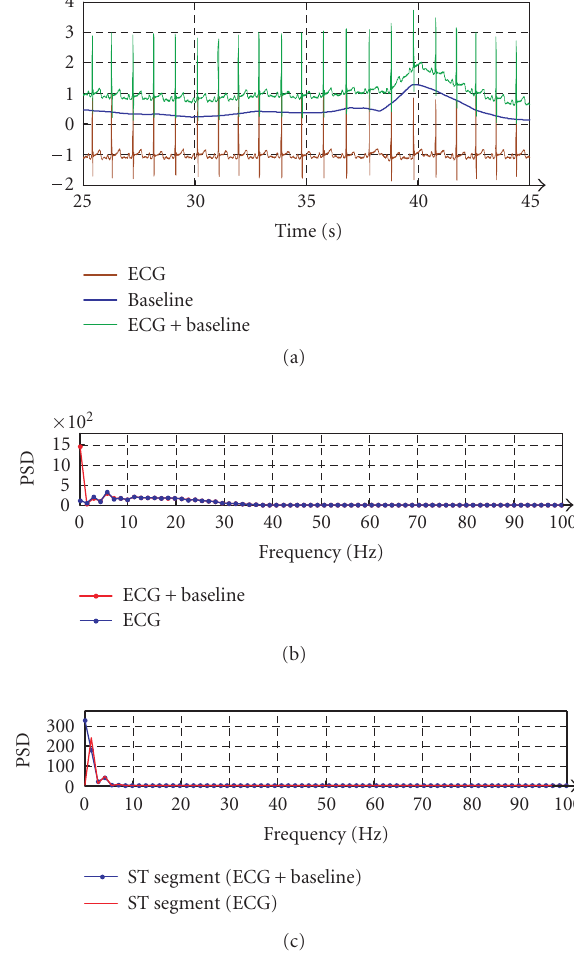
Figure 12: (a) 20 seconds of record “b115-1” highlighted, (b) power spectrum density of record “b115-1,” (c) power spectrum density of ST-segments of record